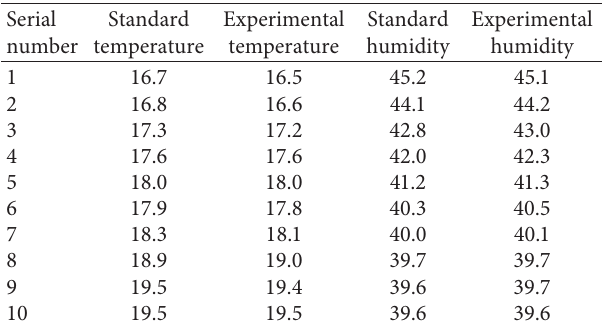
Table 2: Comparison of temperature and humidity monitoring experimental